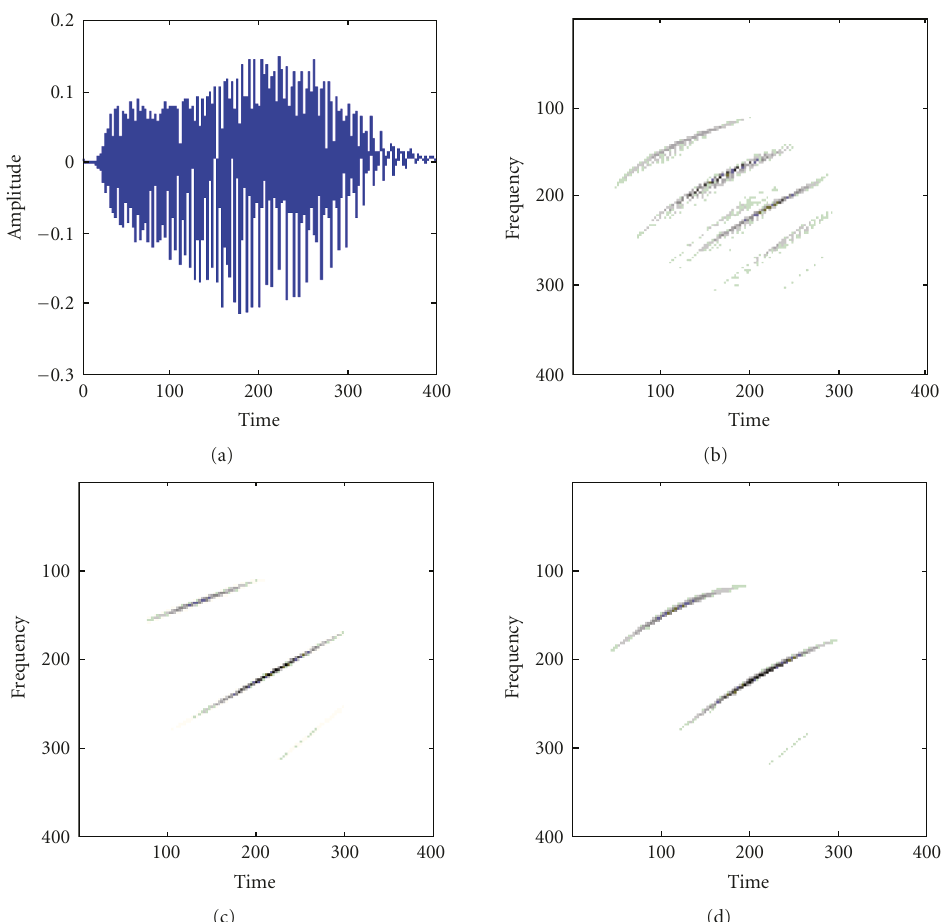
Figure 2: The bat signal and its time frequency distributions: (a) the bat signal, (b) Wigner-Ville distribution, (c) traditional chirplet decomposition, and (d) MACD algorithm.